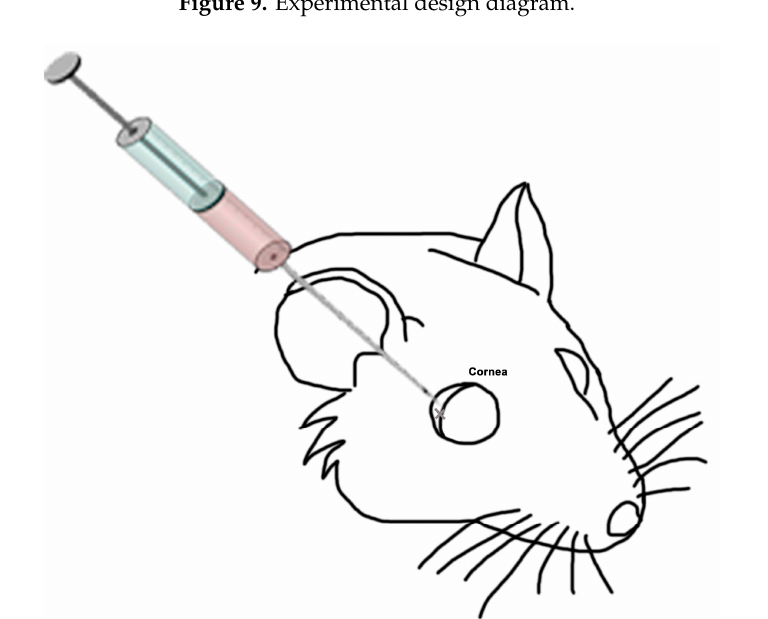
Figure 9. Experimental design diagram.